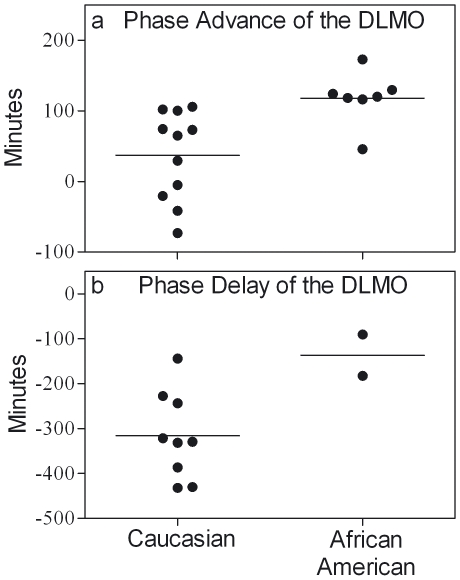
Racial differences in the magnitude of phase shifts to bright-light pulses and shifts of the sleep/dark schedule.Circadian phase advance (a) and phase delay (b) of the DLMO by self-reported race. By convention, phase advances are plotted as positive numbers and phase delays are plotted as negative numbers. Lines indicate the mean of each race.